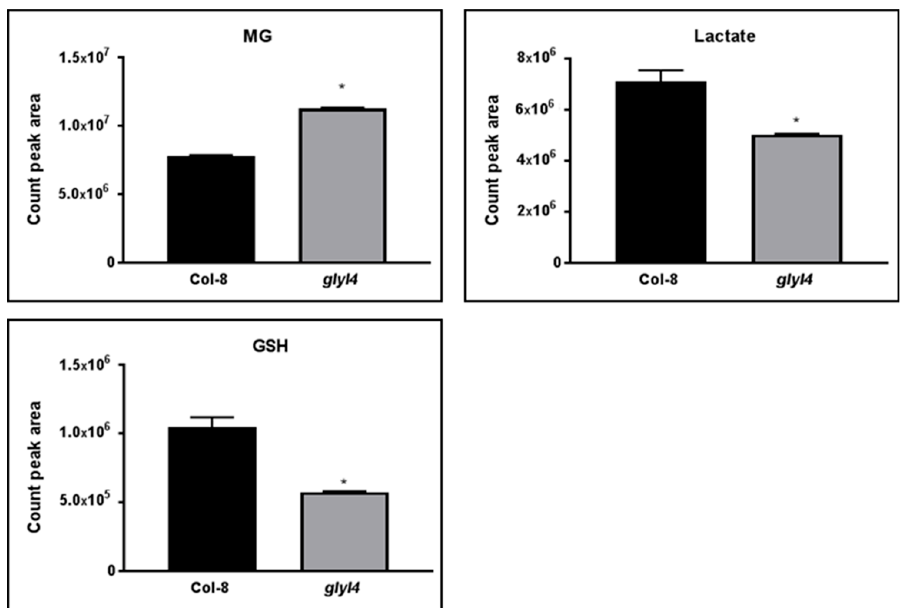
Figure 2. Analysis of MG-scavenging pathway metabolites in Arabidopsis Col-8 and glyI4 mutant. MG, lactate, and glutathione (GSH) amounts were analyzed in Col-8 and glyI4 leaves. Shown data are means of three biological replicates. Error bars represent SEM. Asterisk indicates the statistically significant di ff erence between Col-8 and glyI4 plants ( t -test; * p <